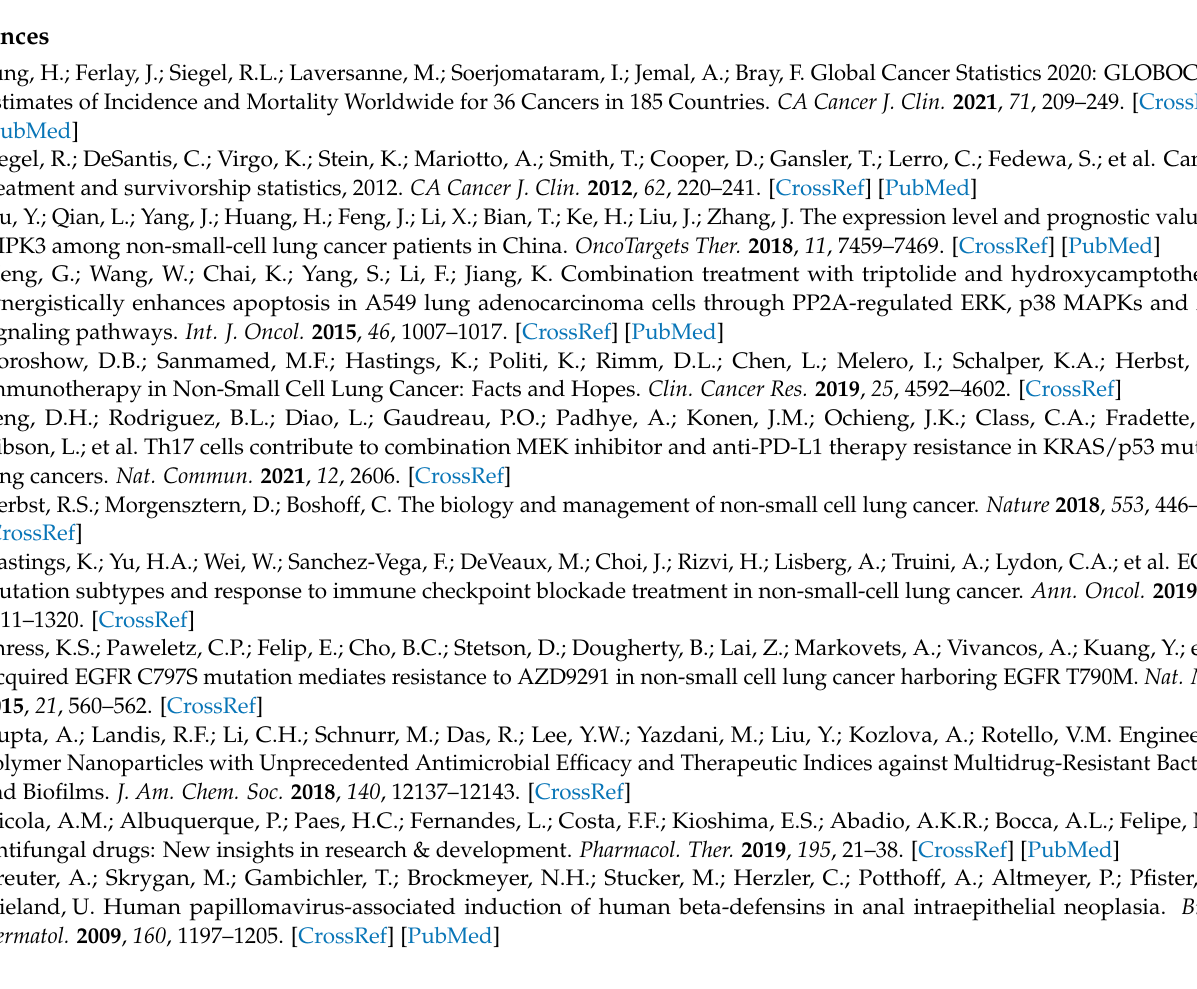
Figure 8 was created with the aid of BioRender